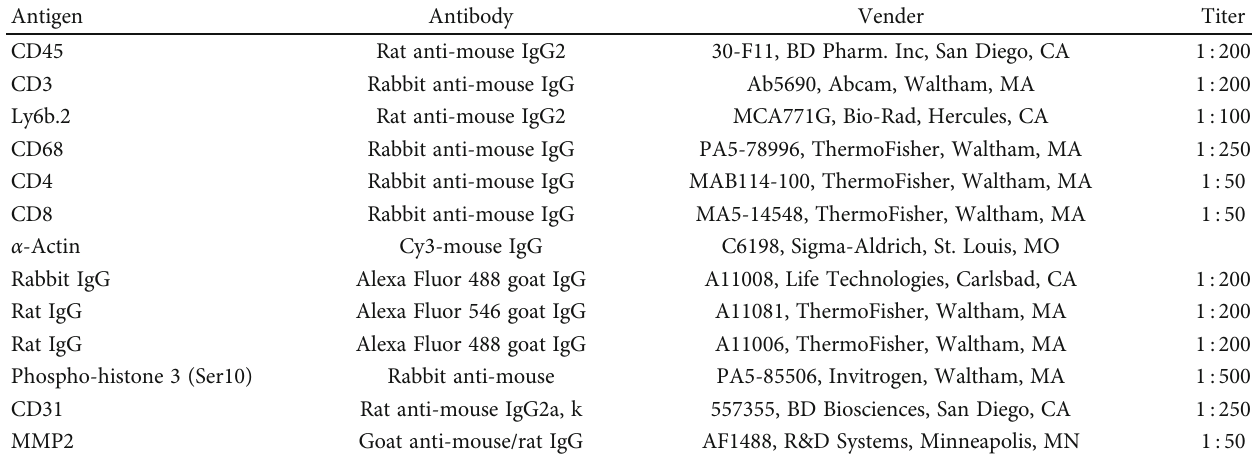
Table 5: Information of antibodies used in this